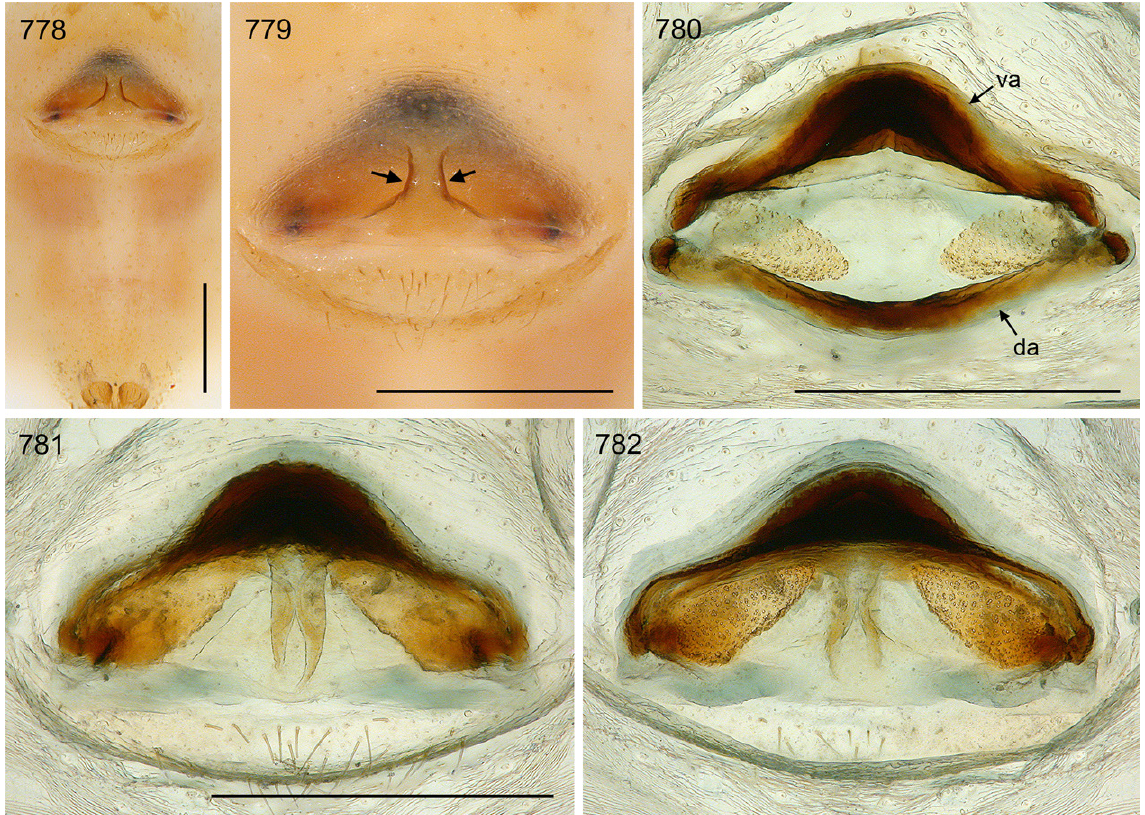
Figs 778–782. Crossopriza sengleti sp. nov.; female from Iran, Fars, Seridjan (MHNG). 778– 779 . Abdomen and epigynum, ventral views; arrows: pockets. 780–782 . Cleared female genitalia, dorsal view with dorsal arc tilted backwards, ventral view, and regular dorsal view. Abbreviations: da = dorsal arc; va = ventral arc. Scale bars = 0.5